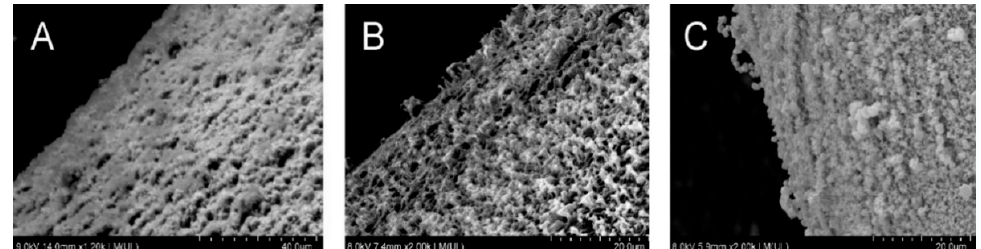
Figure 7. Cryo-SEM images showing gel layer of swollen tablet samples in the 30th min of the